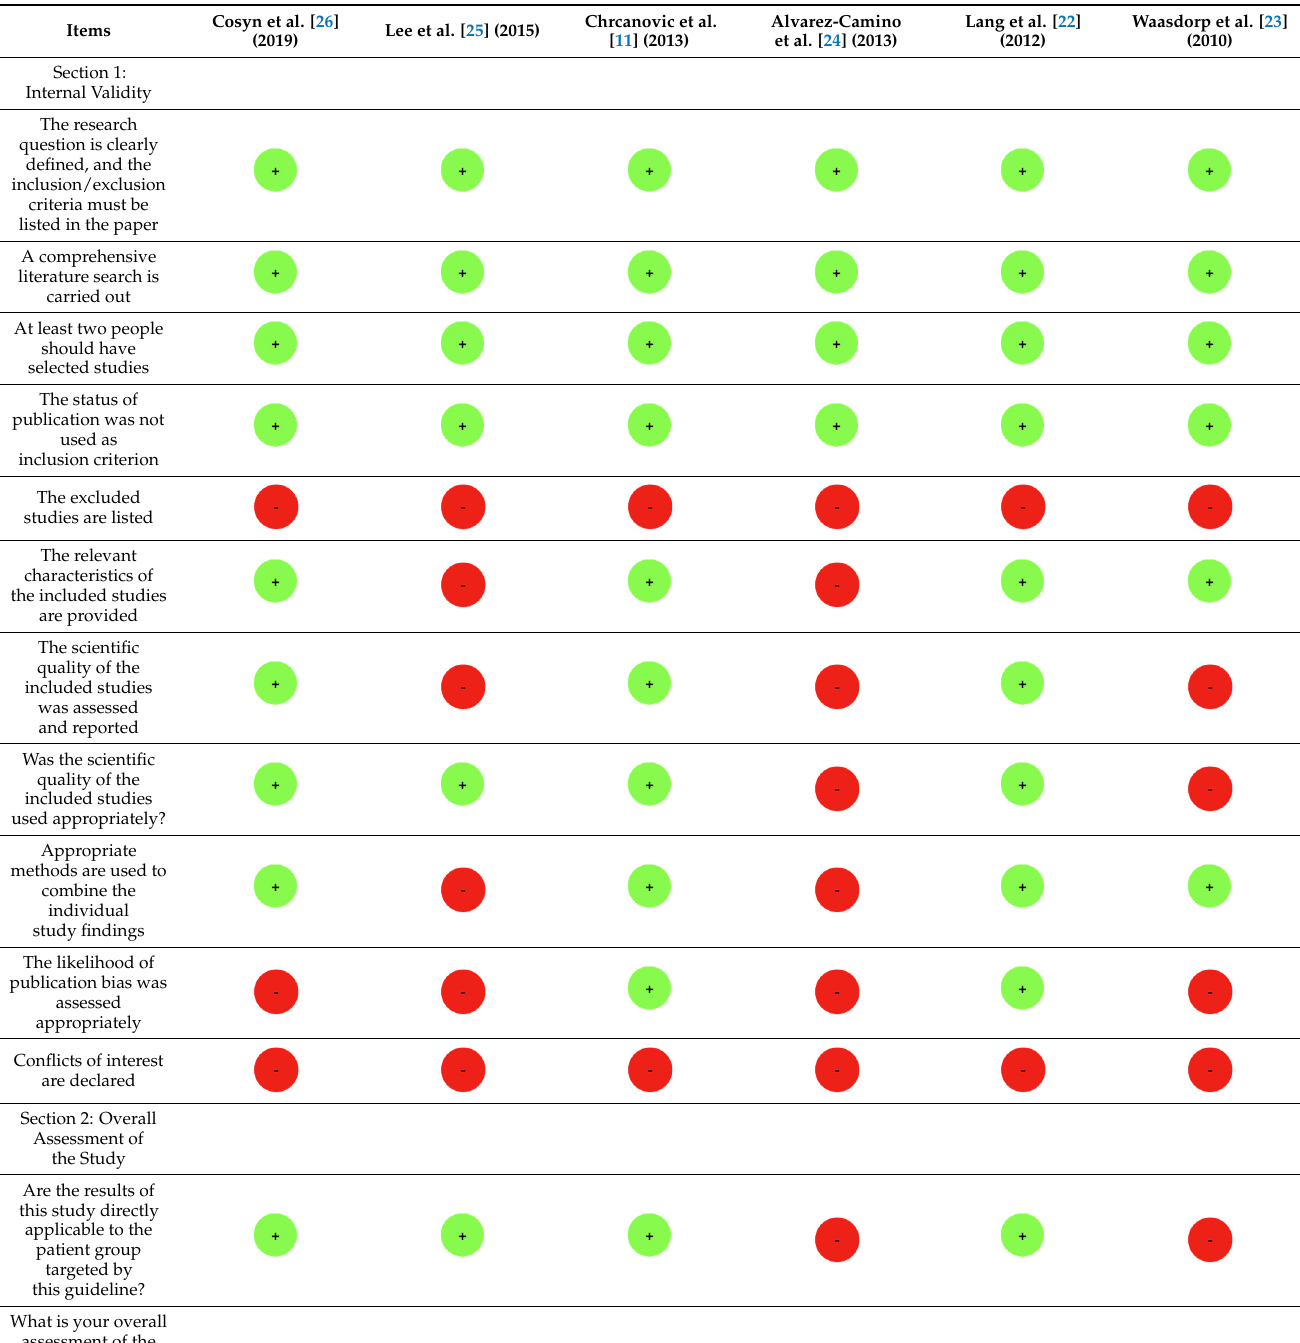
Table 3. SIGN Methodological Assessment Checklist for Systematic Reviews and Meta-Analyses [21].